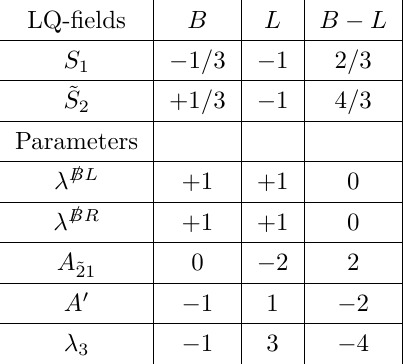
˜ S 2 and parameters (promoted to